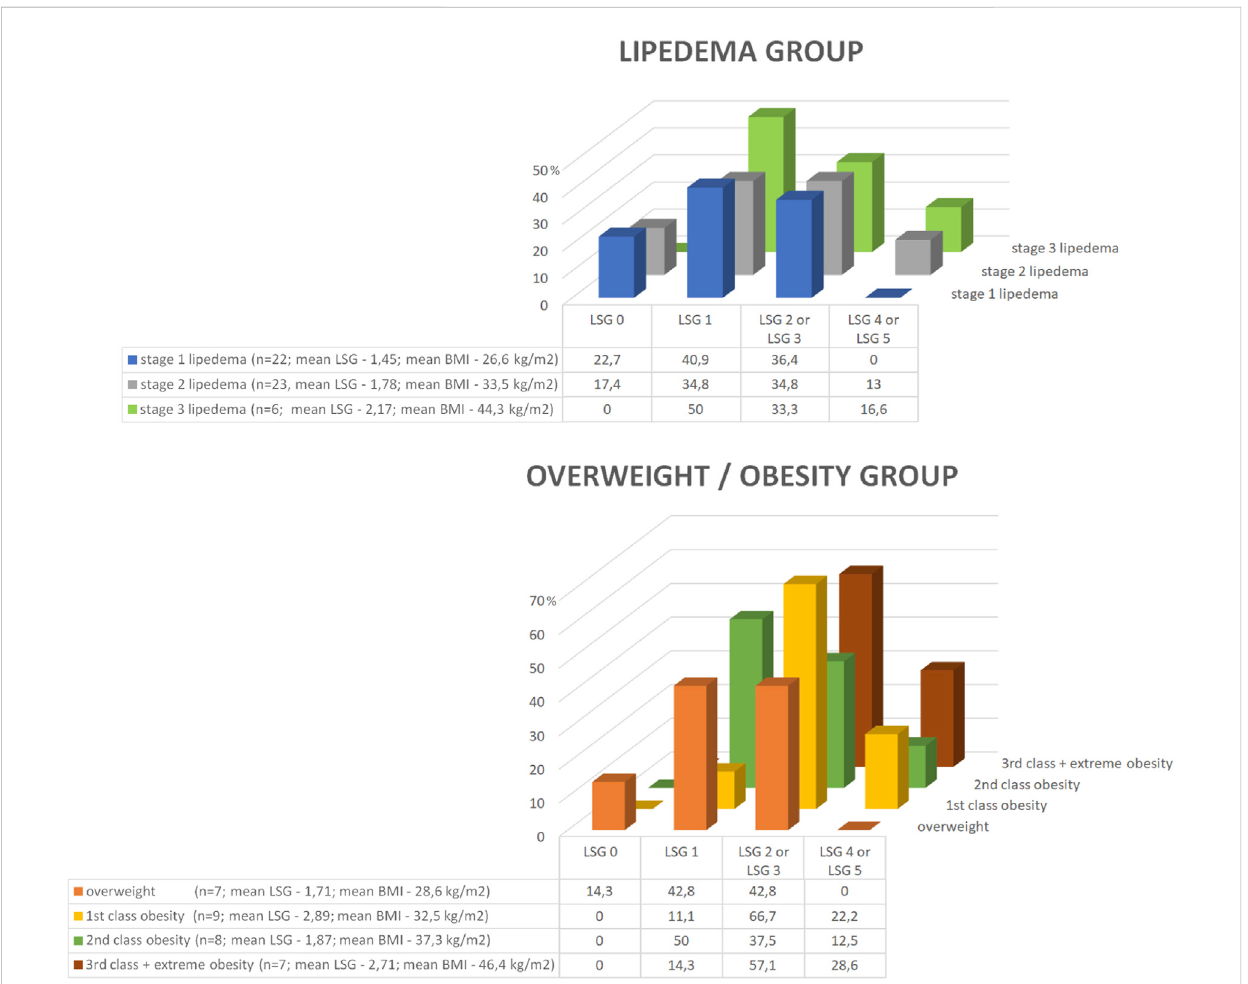
FIGURE 3 Graphically presented lymphoscintigraphic values in relation to stage of lipedema in thelipedema group or thedegreeof obesity inthe overweight/ obesity group. A trend indicating a relationship between stage of lipedema/degree of obesity and lymphoscintigraphic value can be noticed. However, the number of patients in the subgroups divided according to stage of lipedema or degree of obesity was too small for statistically signi fi cant results. Legend: BMI, body mass index; LSG, lymphoscintigraphic